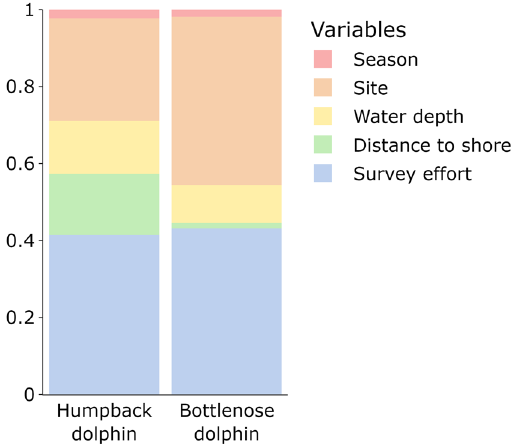
Figure 3. The proportion of variance in the occurrence of Australian humpback ( Sousa sahulensis ) and Indo- Pacific bottlenose dolphins ( Tursiops aduncus ) around the North West Cape, Western Australia, explained by the random effects (i.e., season and site) and the fixed effects (i.e., water depth, distance to shore, and survey effort) included in the joint species distribution